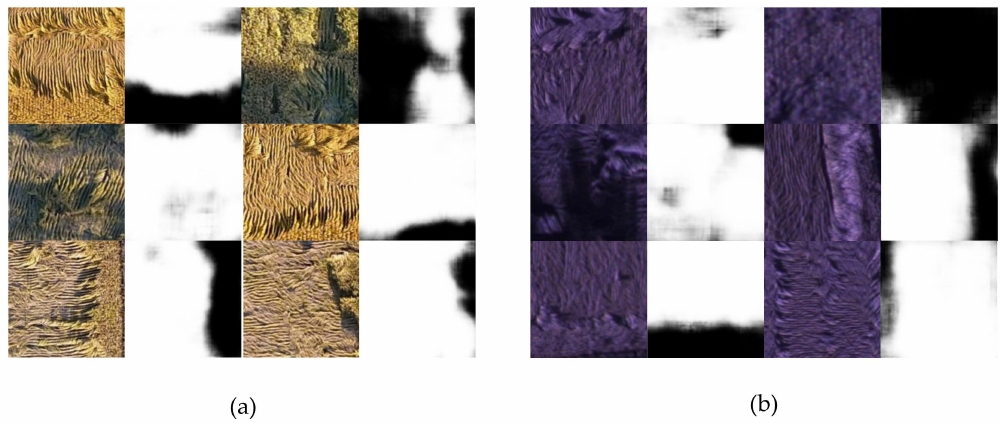
Figure 7. Test dataset segmentation results: ( a ) RGB image test dataset segmentation results; ( b ) multispectral image test dataset segmentation results.